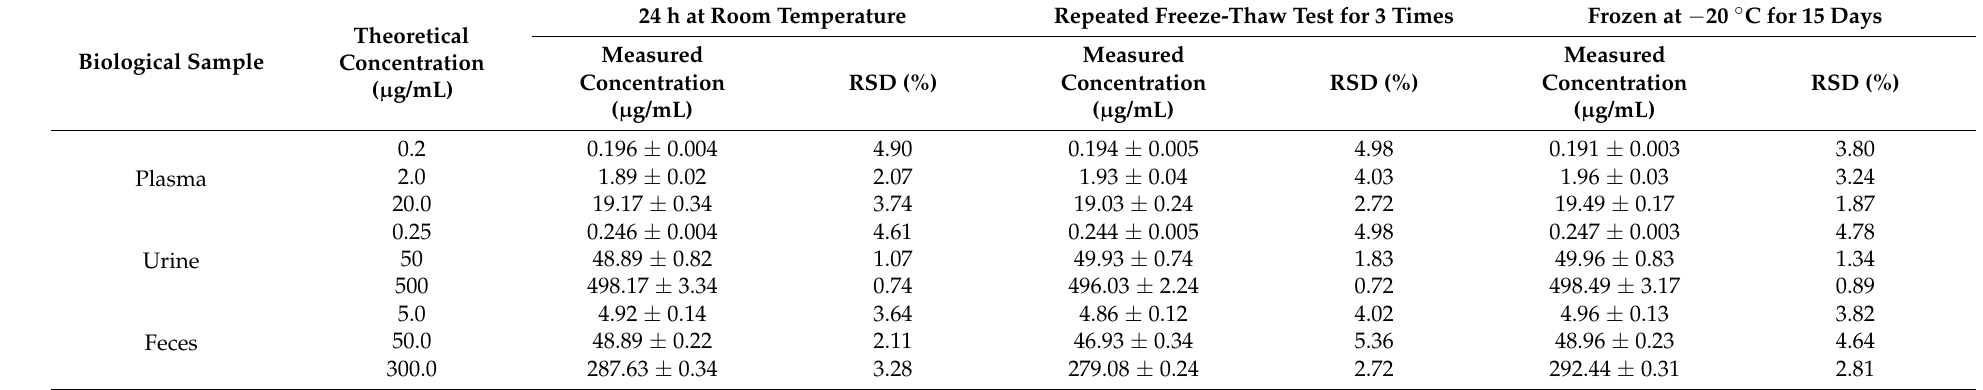
Table 2. Stability in rat plasma, urine, and feces ( n = 5).